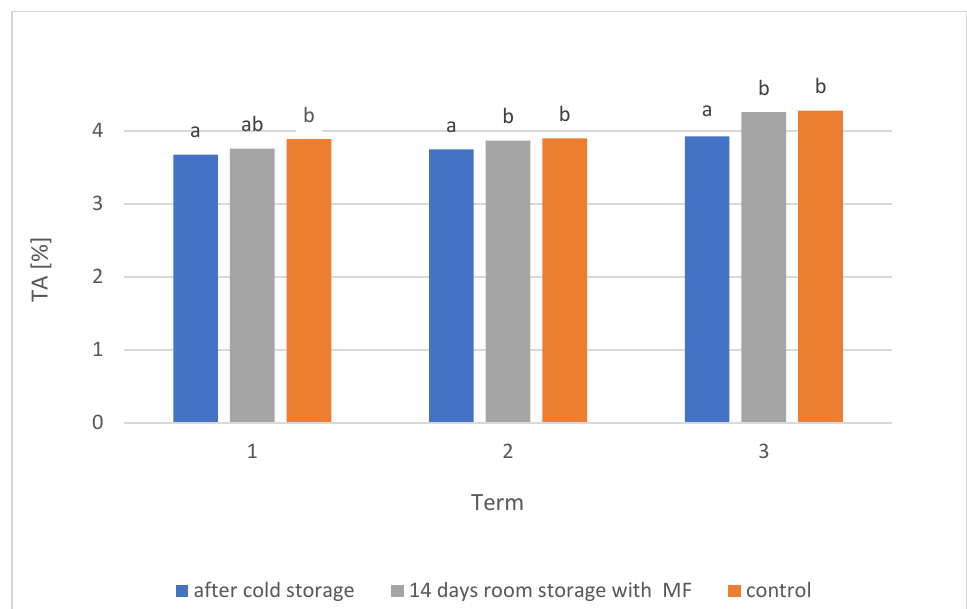
Figure 7. Effects of MF on the TA of Idared apples after 120 days of cold storage. For each experiment, apples were stored in room conditions for 14 days. Statistically significant differences are marked by different letters. Differences between average values that are marked with the same letters (a – b) are not statistically significant. The data were analysed separately for each experiment .